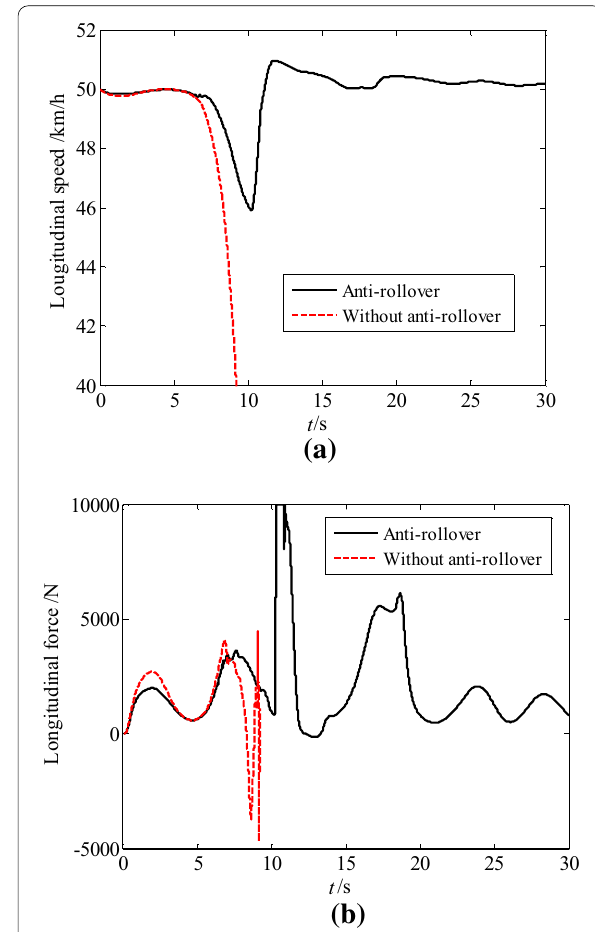
Figure 16 Longitudinal dynamics of the intelligent heavy truck in Scenario 3: ( a ) Longitudinal speed; ( b ) Longitudinal